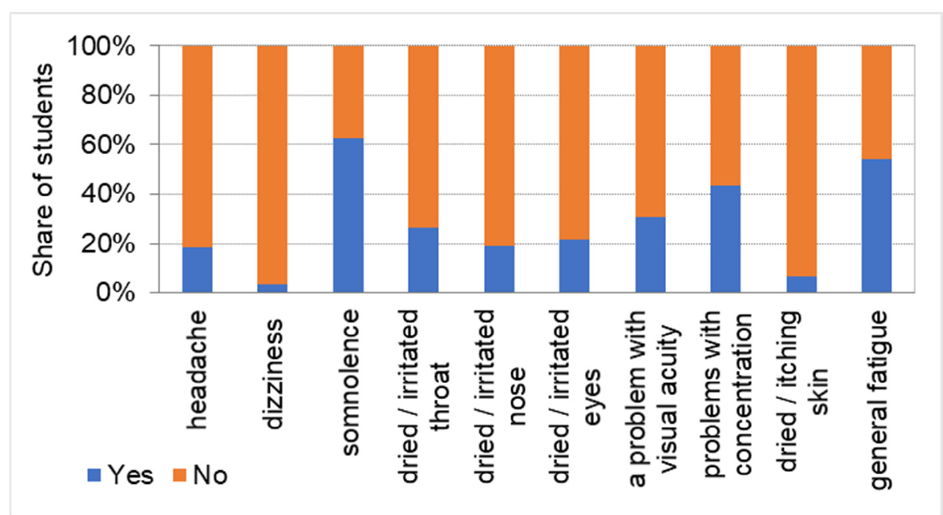
Figure 12. The percentage distribution of students’ perceptions and feelings.